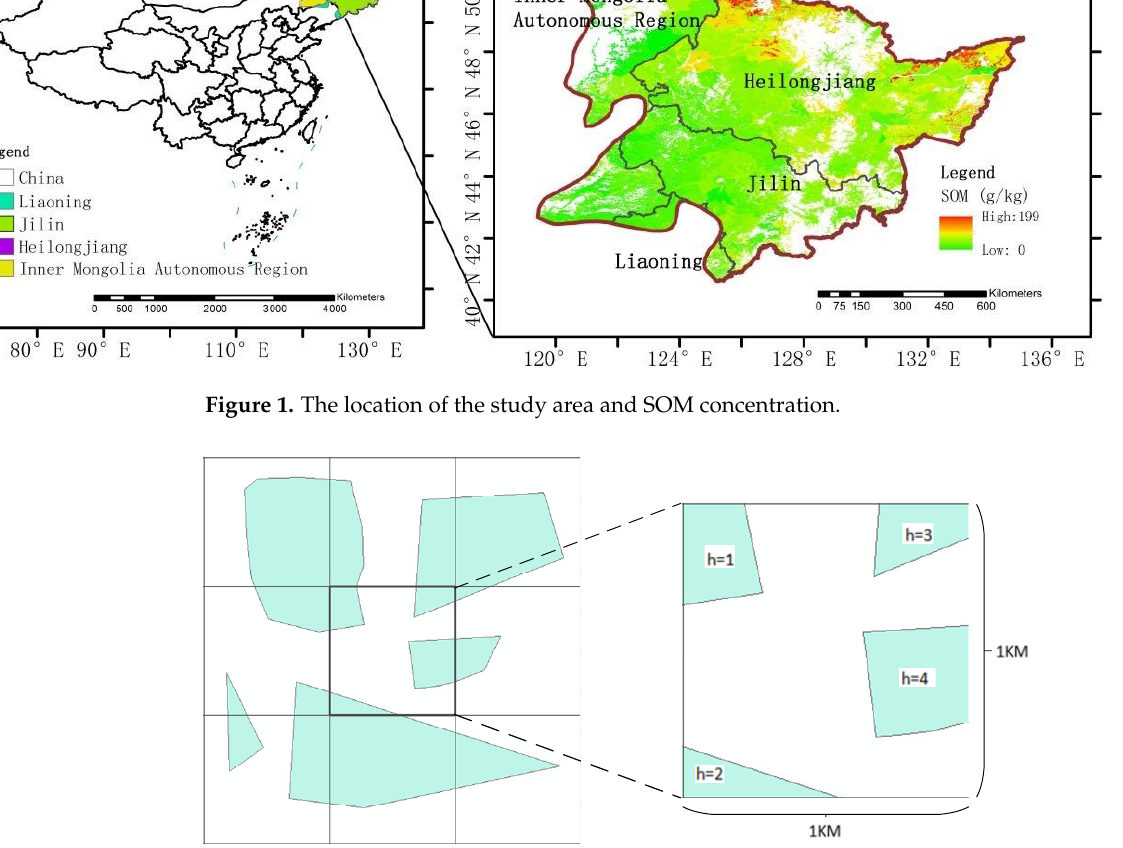
Figure 2. Transferring the spatial support of SOM.